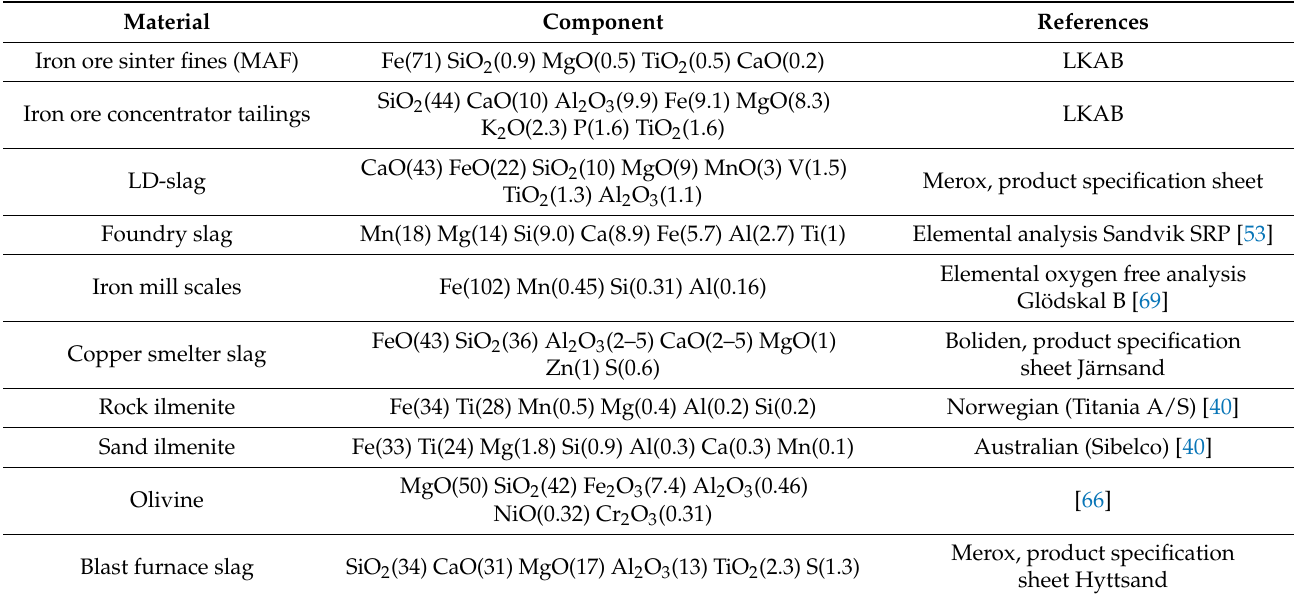
Table 4. Composition of representative samples of the materials. Note that some entries present composition as oxides, some as elements. Balance is mainly